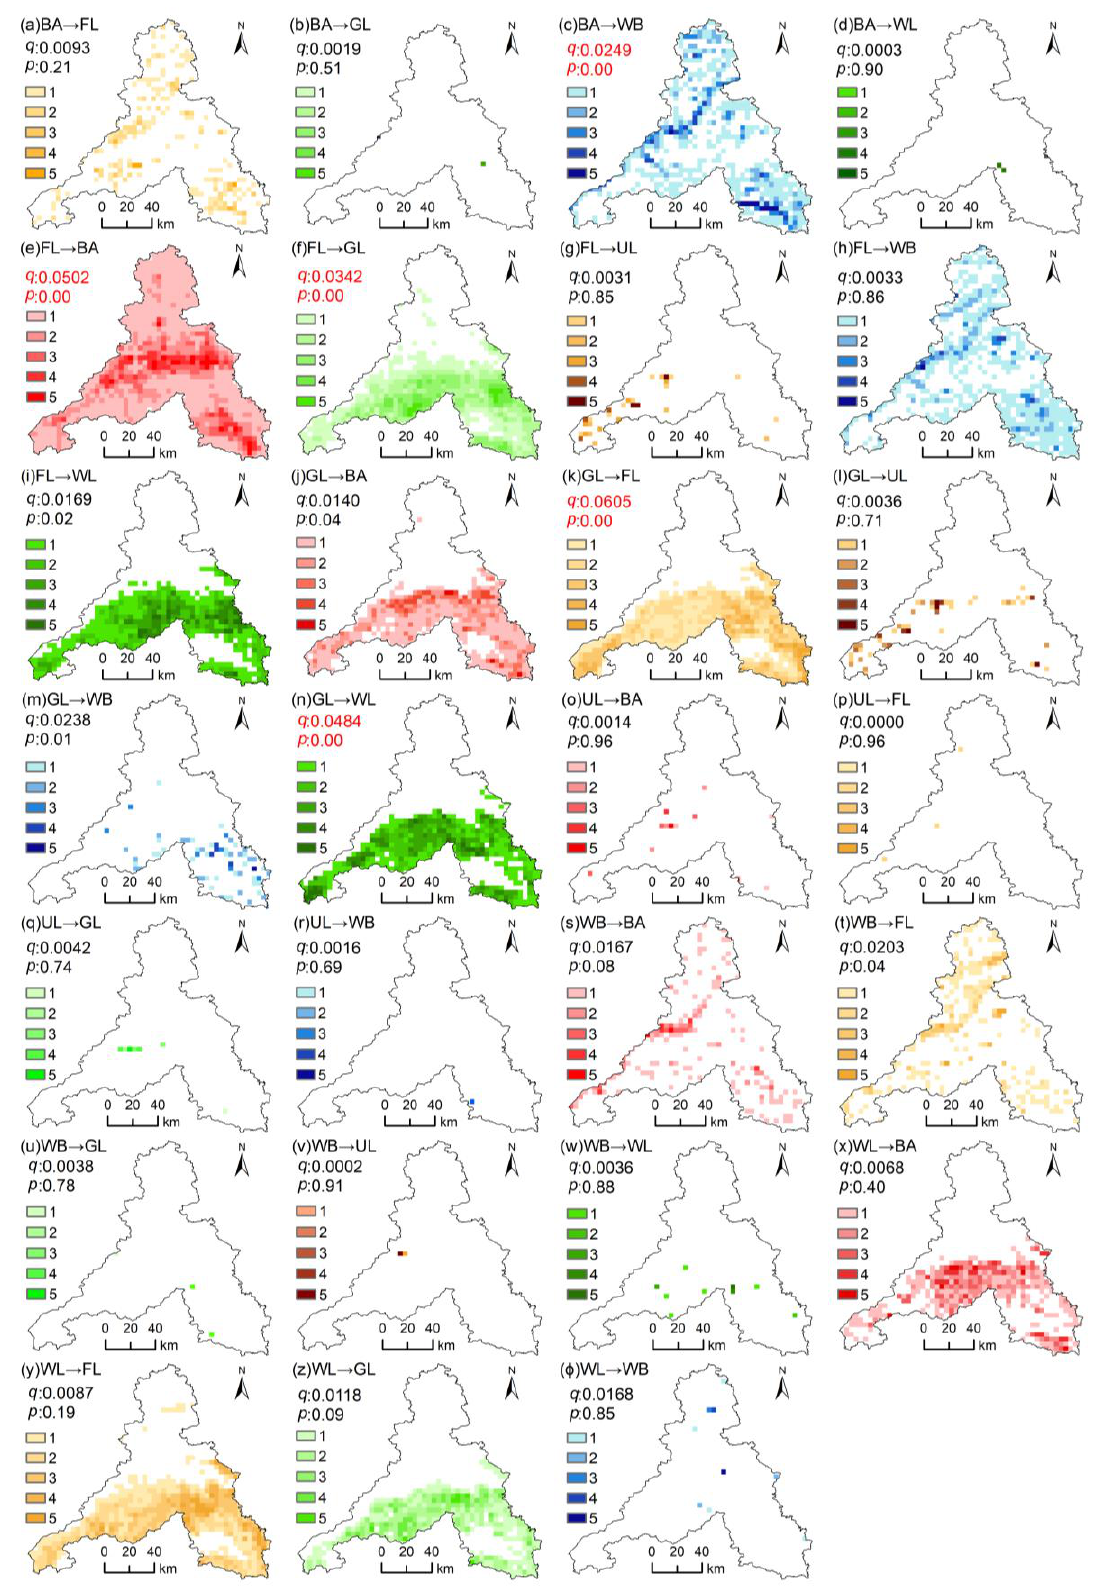
Figure 11. Factor detection results of ecological quality changes from 2000 to 2010: ( a ) – ( ϕ ) show the spatial distribution of land use/land cover transfers from 2000 to 2010, respectively. The q and p values in each figure indicate the explanatory power and significance of that spatial distribution on ecological quality changes.